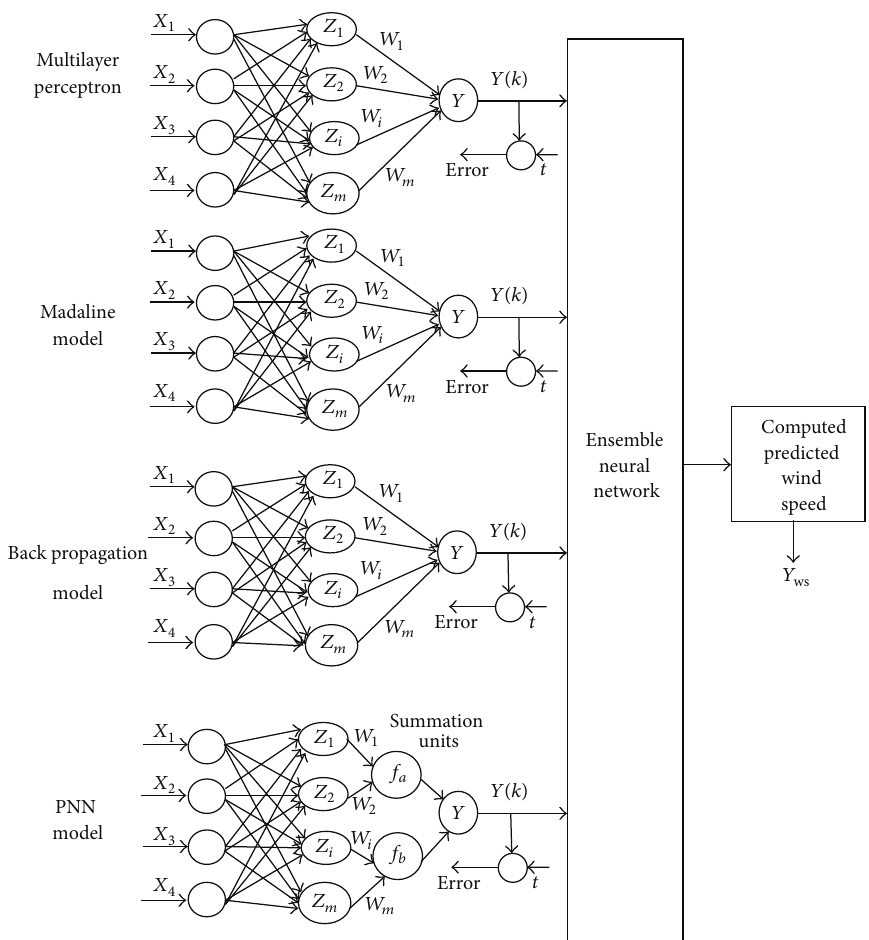
Figure 2: The proposed architectural model of ensemble neural